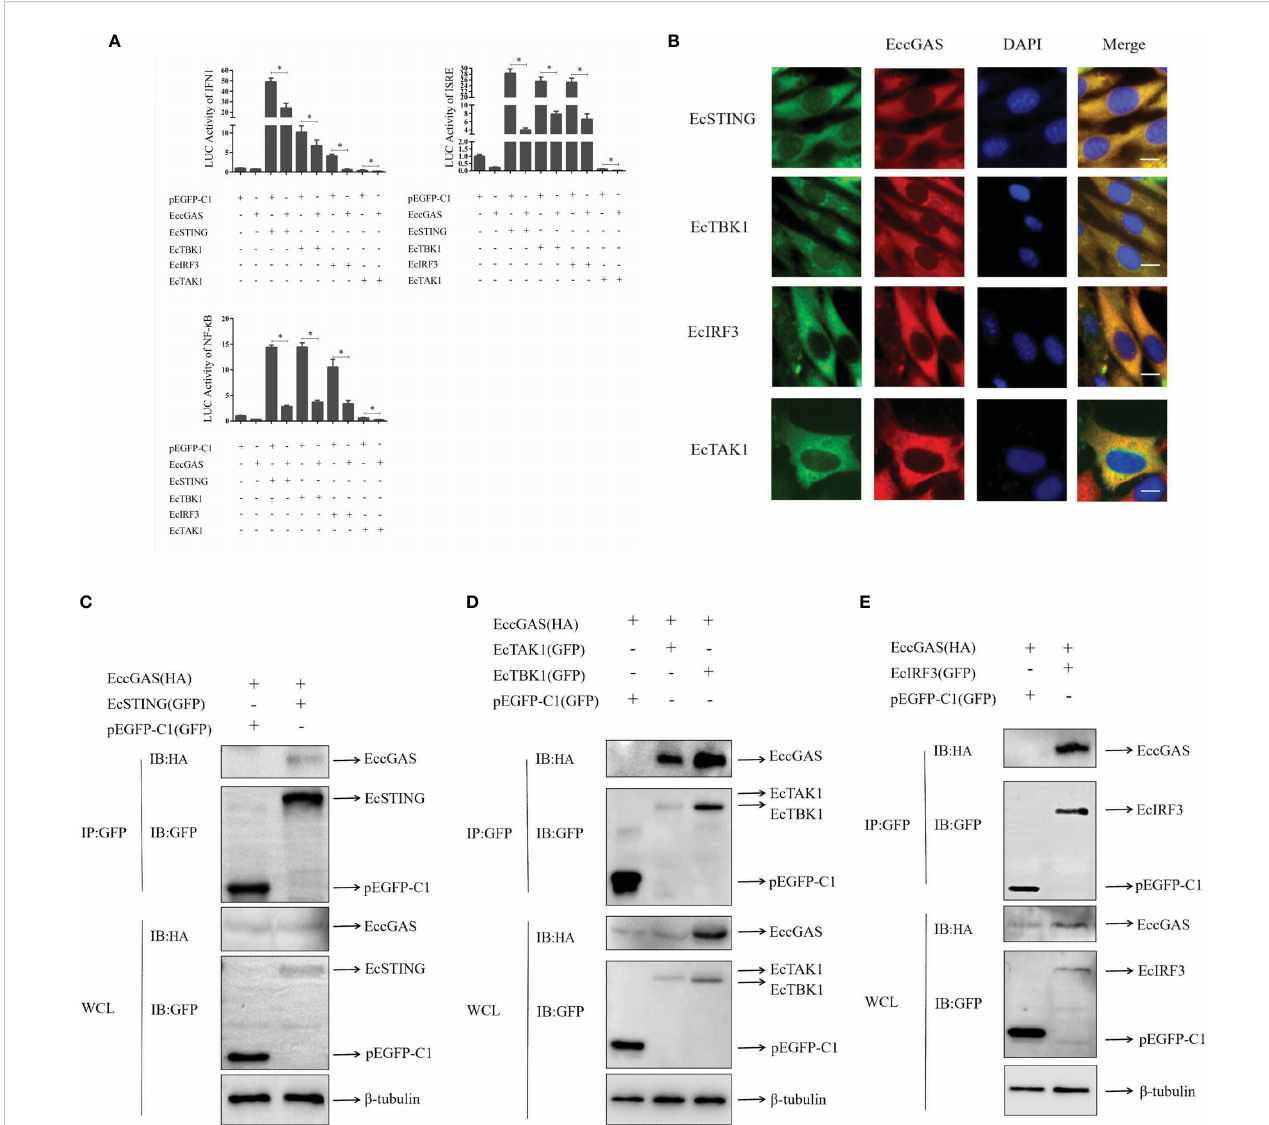
FIGURE 7 EccGAS negatively regulates EcSTING-mediated immune responses. (A) EccGAS inhibits the activation of IFN1, ISRE, and NF- k B promoter induced by EcSTING, EcTBK1, EcTAK1 and EcIRF3. pEGFP-EcSTING, pEGFP-EcTBK1, pEGFP-EcTAK1, and pEGFP-EcIRF3 were transfected into GS cells at a ratio of 1:1:1 with pEGFP- EcGAS and IFN1-Luc, respectively. Cells were harvested for detection of luciferase activity at 36 h after transfection.The error bars indicate mean ± SD; * P < 0.05. ISRE and NF- k B promoter activities were tested in the same way. (B) EccGAS colocalized with EcSTING, EcTBK1, EcTAK1 and EcIRF3, respectively. The plasmid pcDNA3.1-Red-EccGAS was co-transfected with pEGFP-EcTBK1, pEGFP-EcTAK1 and pEGFP-EcIRF3 in GS cells, respectively. Imaged by confocal microscopy, scale bars are shown at 20 m m. (C – E) EccGAS interacts with EcSTING, EcTBK1, EcTAK1 and EcIRF3, respectively. pEGFP-C1, pEGFP -EcSTING, pEGFP-EcTAK1, pEGFP-EcTBK1, and pEGFP-EcIRF3 were cotransfected with pcDNA3.1-EccGAS in GS cells, respectively. Samples were processed by immunoprecipitation and western blotting. b -tubulin was used as an internal